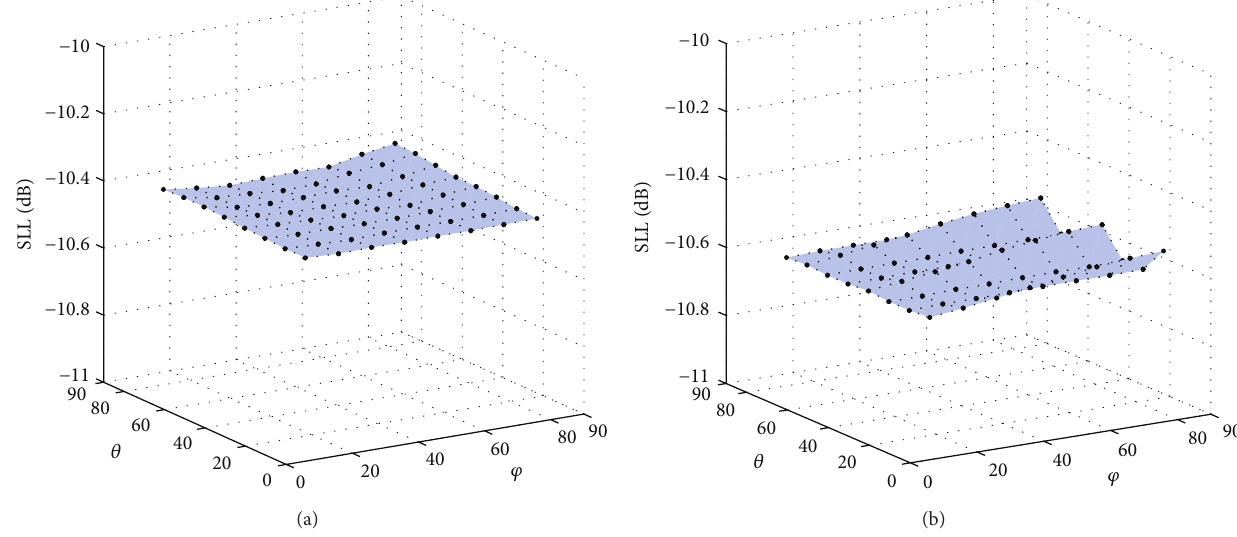
Figure 6: Behavior of peak SLL when the main beam is steered in the optimized directions for (a) RA and (b) UCRA.